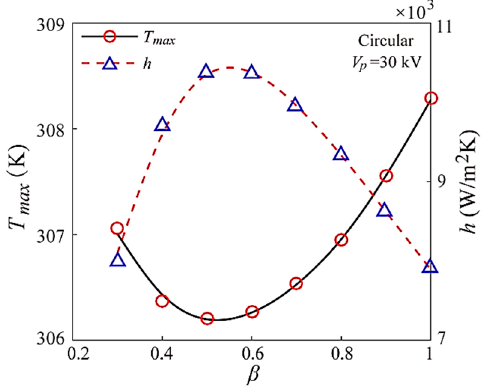
Figure 6. Effect of daughter-to-parent channel diameter ratio on the maximum temperature and average convective heat transfer coefficient of the Y-shaped circular MCHS.